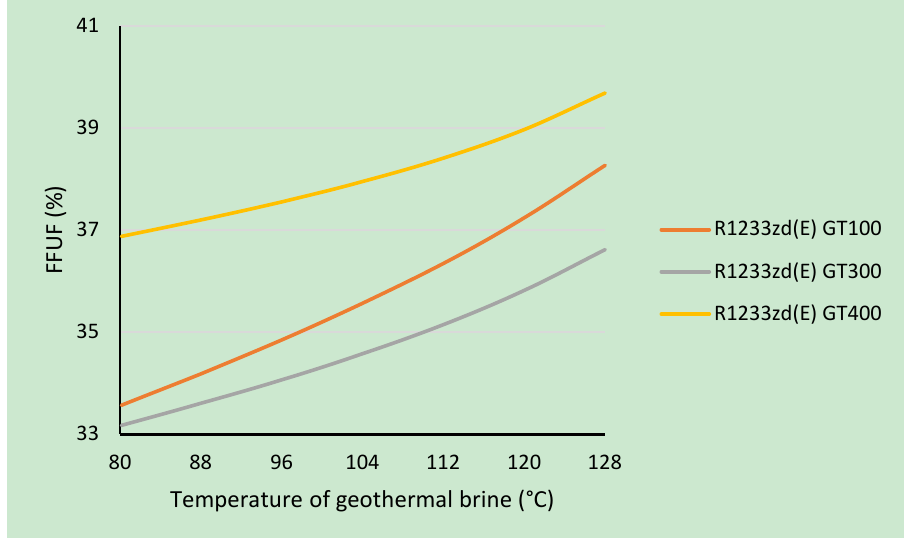
Figure 12. The fossil fuel utilization factor (FFUF) of modified ORC installation assisted by a gas turbine as a function of the geothermal brine temperature with R1233zd(E) as a working fluid for different gas turbine types.